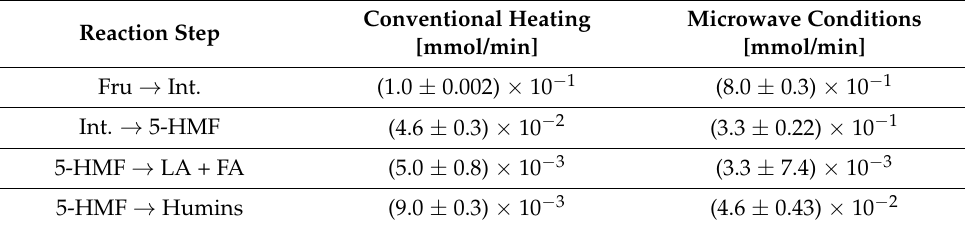
Table 7. Rate coefficients at 150 ◦ C calculated using the values listed in Table 6 in Equations (1) and